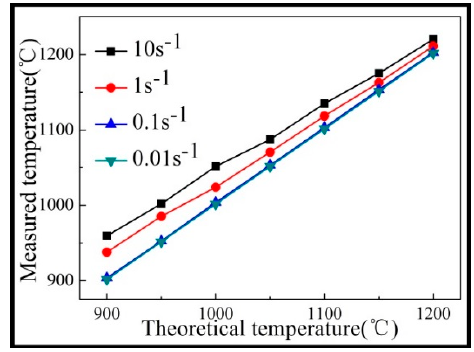
Figure 3. Adiabatic heating effect of the Inconel625 alloy during hot compression.